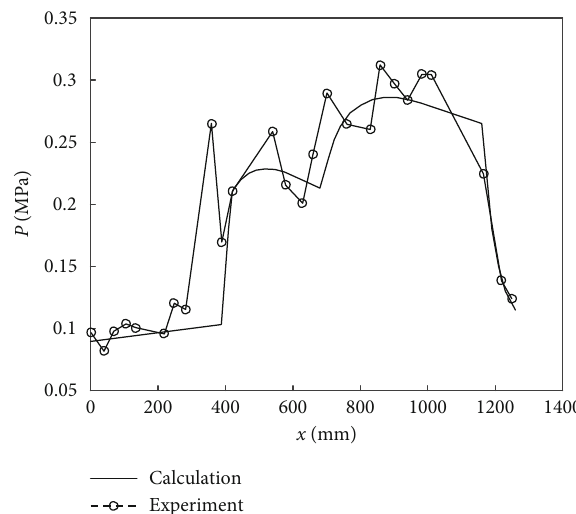
Figure 10: Comparison of computational results and experimental data obtained by the research group at HIT.